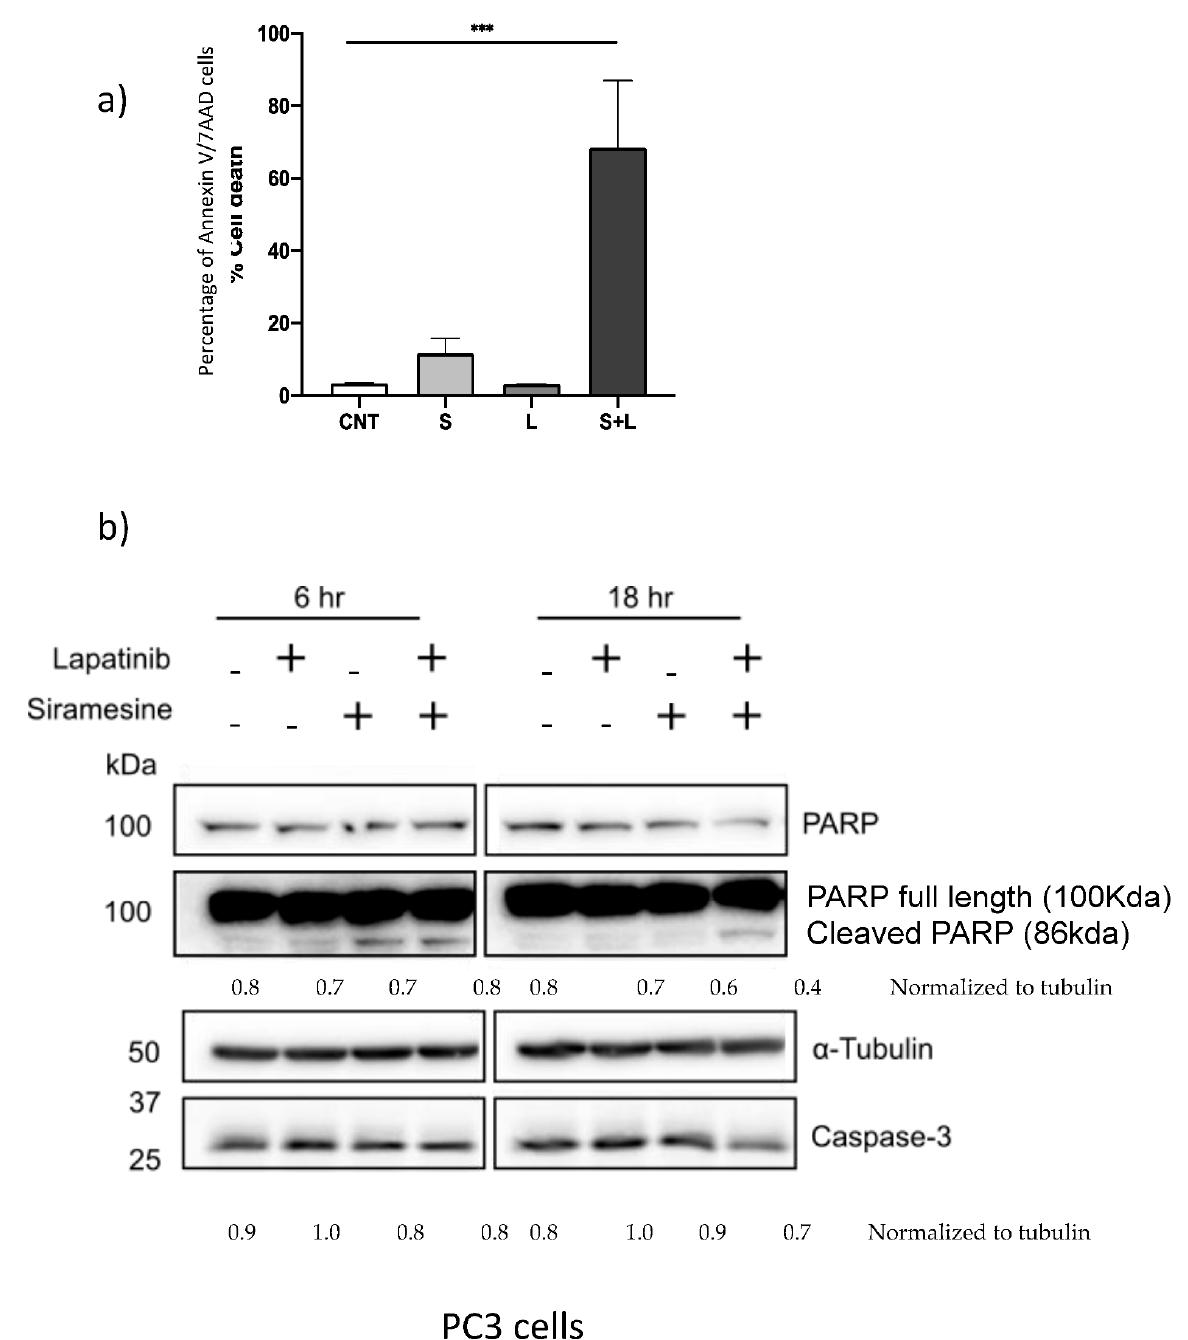
Figure 5. Siramesine and lapatinib induce apoptotic cell death . PC3 cells were treated with siramesine alone (S, 10 μ M), lapatinib alone (L, 0.5 μ M) or in combination. ( a ) After 24 h, cells were incubated with AnnexinV/7AAD dyes for 15 min and analyzed by flow cytometry. ( b ) Cells were lysed after 6 and 12 h of treatment and protein expression for PARP, and cas-3 were determined by western blot. Tubulin was used as a loading control a. Results are representative of three independent replicates ( n = 3).